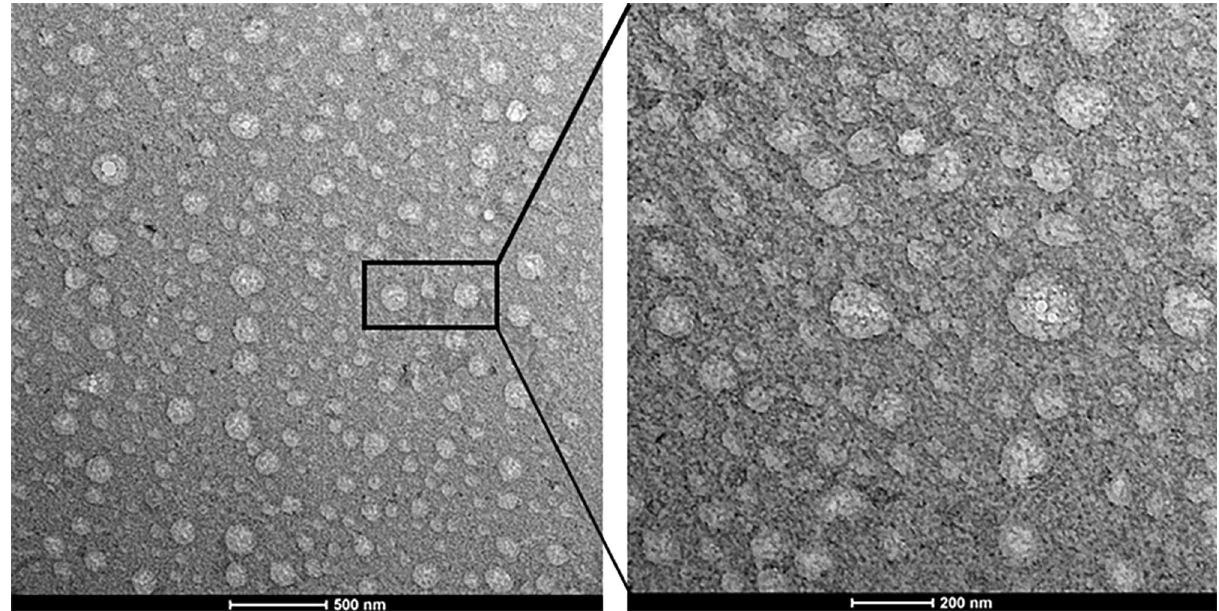
Figure 1. Transmission electron microscopic image of extracellular vesicles of aqueous humor. Numerous extracellular vesicles (EVs) with round shape morphology with various size (left, bar: 500 nm). On higher magnification, EVs up to 170 nm in size are present (right, bar: 200 nm).